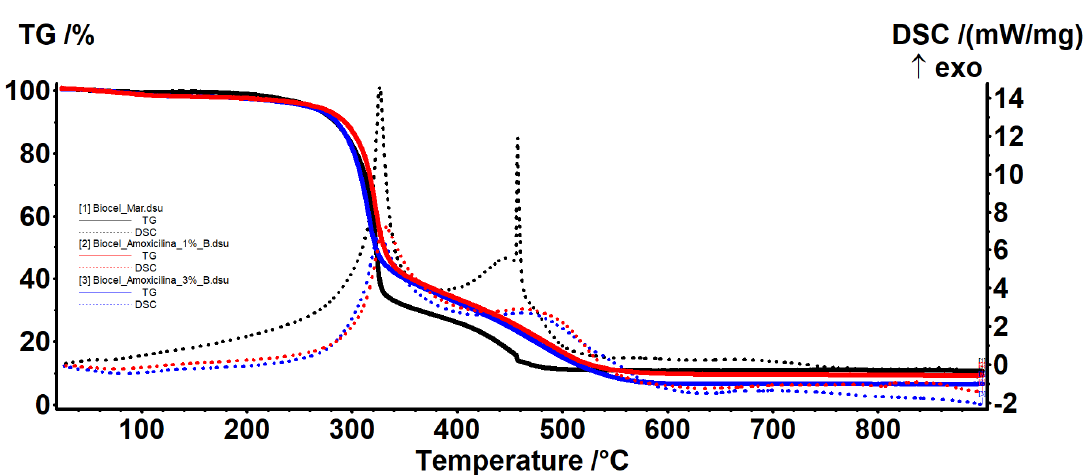
Figure 6. Thermal analysis of BC-amoxicillin 1% and 3%. Table 3. Residual mass of